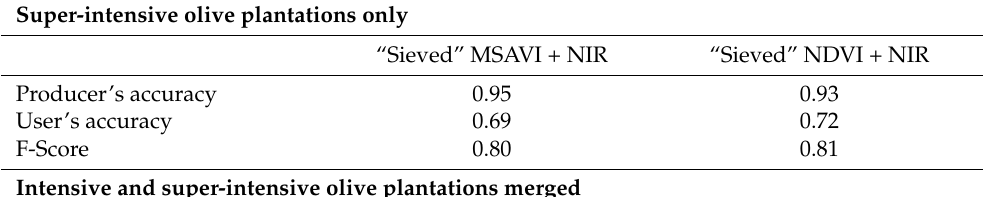
Table 9. Producer’s and user’s accuracy and F-Score of “sieved” cluster, before and after merging intensive and super-intensive olive